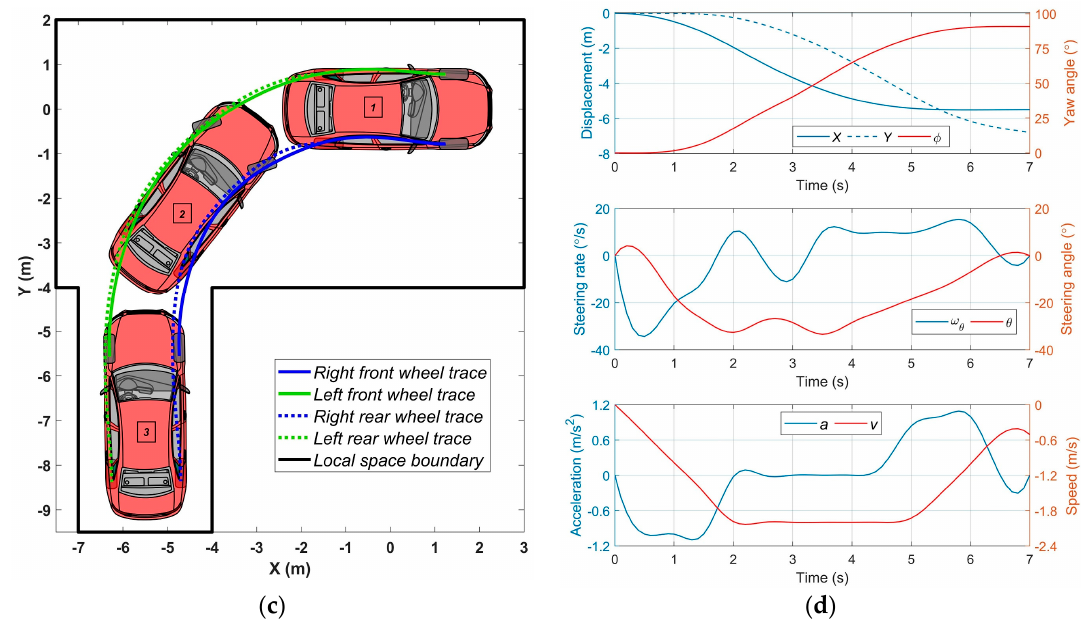
Figure 3. Simulation results for reverse parking of a passenger car: ( a ) Position and trajectory (parallel reverse); ( b ) Basic parameters (parallel reverse); ( c ) Position and trajectory (perpendicular reverse); ( d ) Basic parameters (perpendicular reverse). Infrastructures 2020 , 5 , x FOR PEER REVIEW